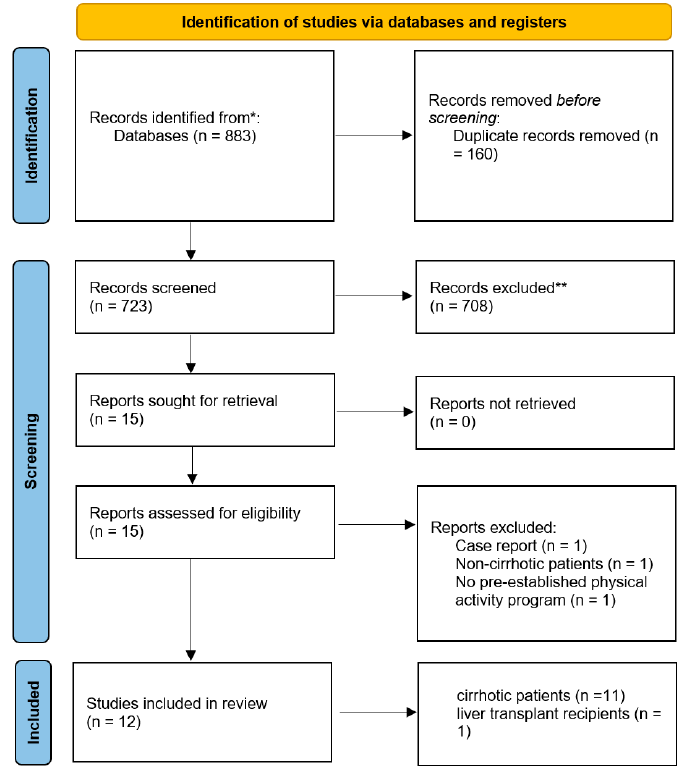
Figure 2. Flow diagram of the systematic review.